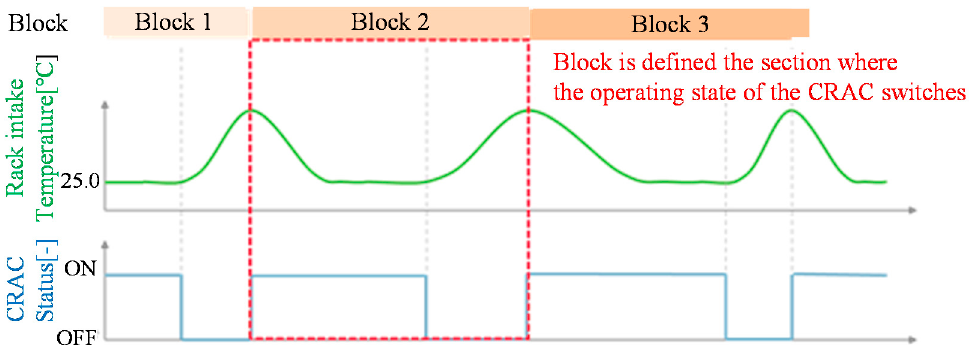
Figure 12. Image of gradient boosting decision tree (GBDT).